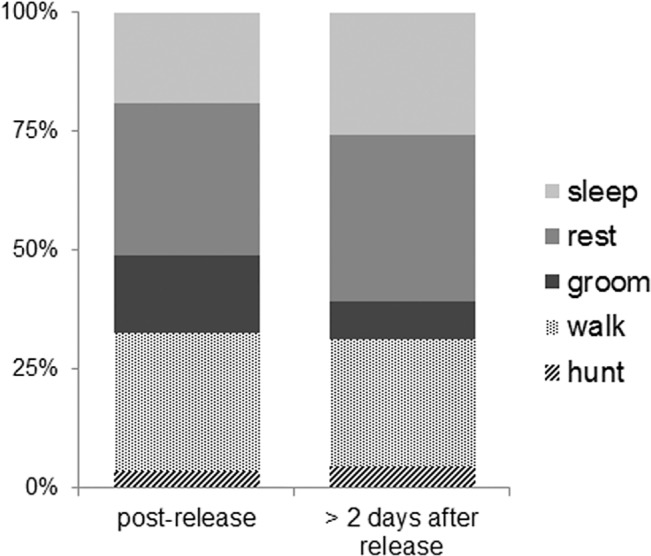
Activity budgets of feral cats during footage obtained within eight hours of capture and release (left column, 61 hours) and footage obtained two or more days post release (right, 28 hours).